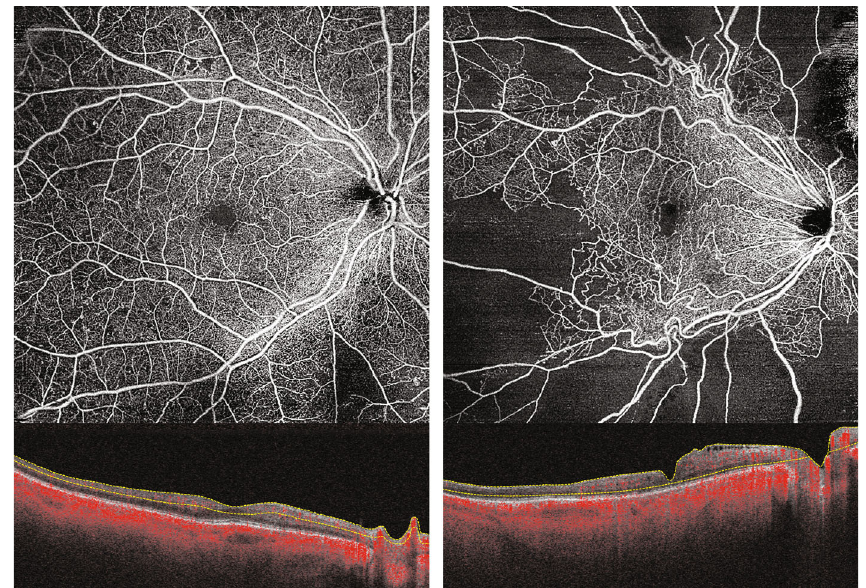
Figure 1: Two patients with diabetic retinopathy showing di ff erent degrees of capillary